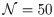
Monte Carlo simulation of N = 20 simultaneous random walkers visiting N=50 locations on the plane.Each random walker visits independently these locations with a strategy defined by Eq (1) with parameters α → ∞ and R = 0.25. We choose the parameter M, characterizing the memory of the walker, as M = 20 and the number of encounters to establish a link is two (c = 2). In the left panels we plot the trajectories of the walkers in the plane and in the right we plot the encounter network for different times: (a) t = 10, (b) t = 20, (c) t = 50, (d) t = 100. In the Supporting Information (S1 Video), we include the complete simulation for 0 ≤ t ≤ 100.